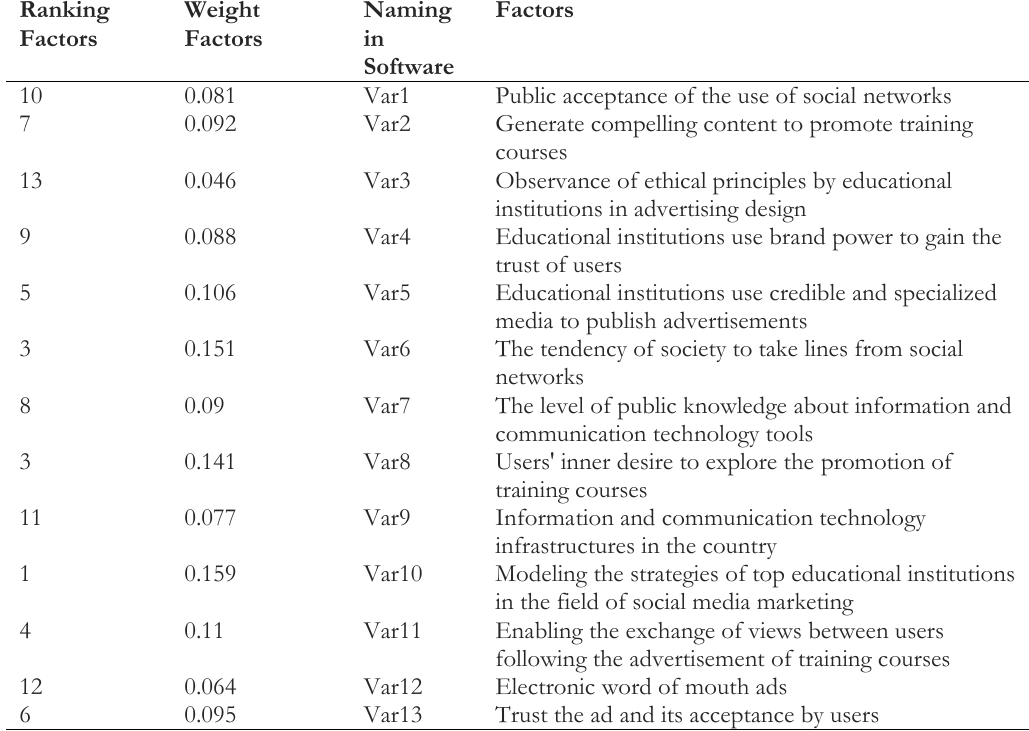
Table 3. Prioritizing factors using